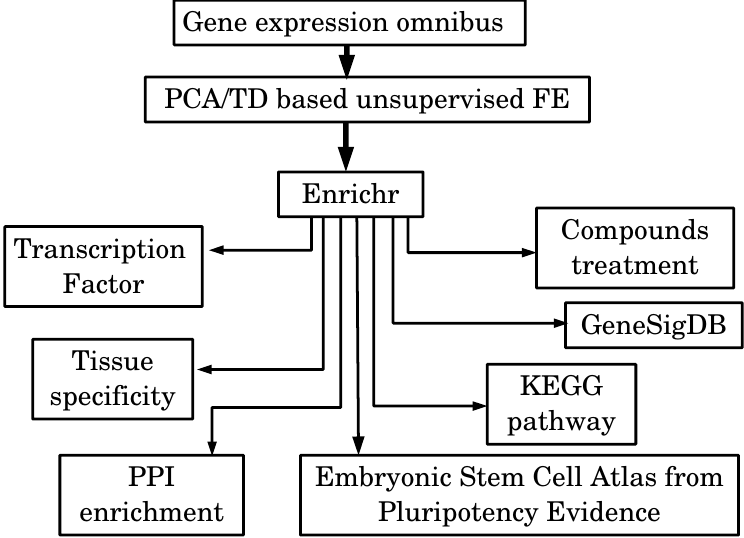
Figure 2. A schematic diagram that summarizes the obtained